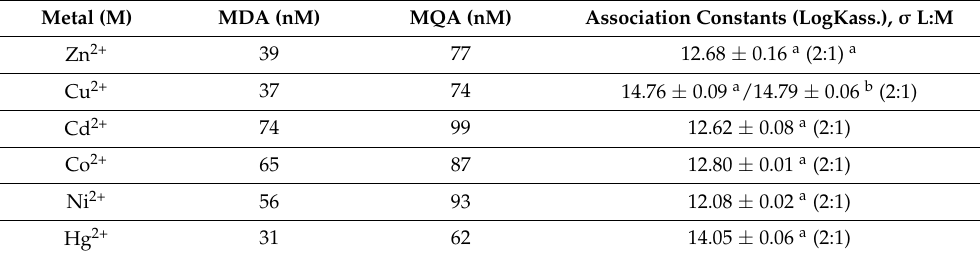
Table 1. Minimal detectable (MDA) and quantified amounts (MQA) of metal ions by Cy1 . Stability as- sociation constants of Cy1 with metal ions in acetonitrile ( σ is an estimate of the average experimental error, a determined by absorption, b by